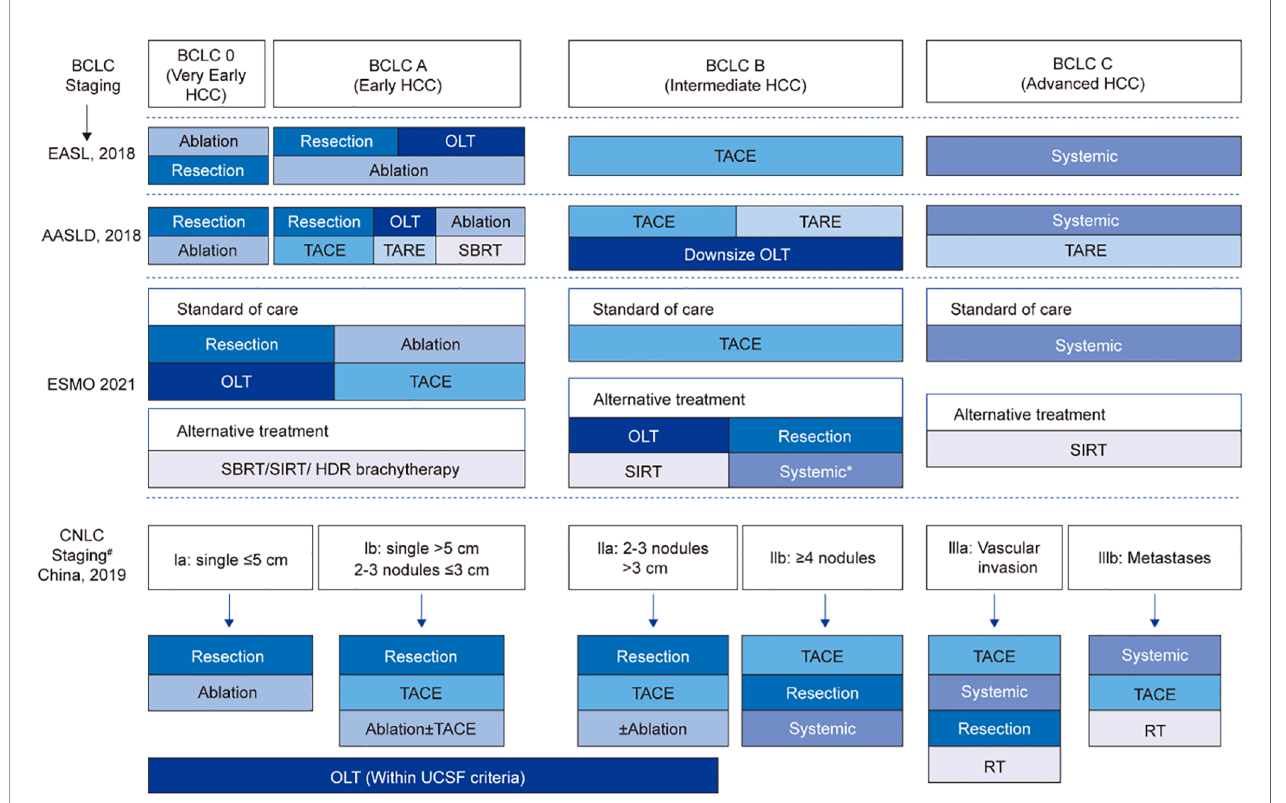
FIGURE 1 | Comparisons of staging and treatment algorithms of HCC among 2021 ESMO, 2018 EASL, 2018 AASLD, and 2019 Chinese guidelines. *For patients who are not suitable for local therapies; # If PS = 0-2, CNLC stage I-III; if PS > 2, CNLC stage IV; BCLC, Barcelona Clinic Liver Cancer; EASL, European Association for the Study of the Liver; AASLD, American Association for the Study of Liver Diseases; CNLC, China liver cancer staging; OLT, orthotopic liver transplantation; TACE, transarterial chemoembolization; TARE, transarterial radioembolization; SBRT, stereotactic body radiotherapy; SIRT, selective internal radiotherapy; RT, radiation therapy; UCSF, University of California San